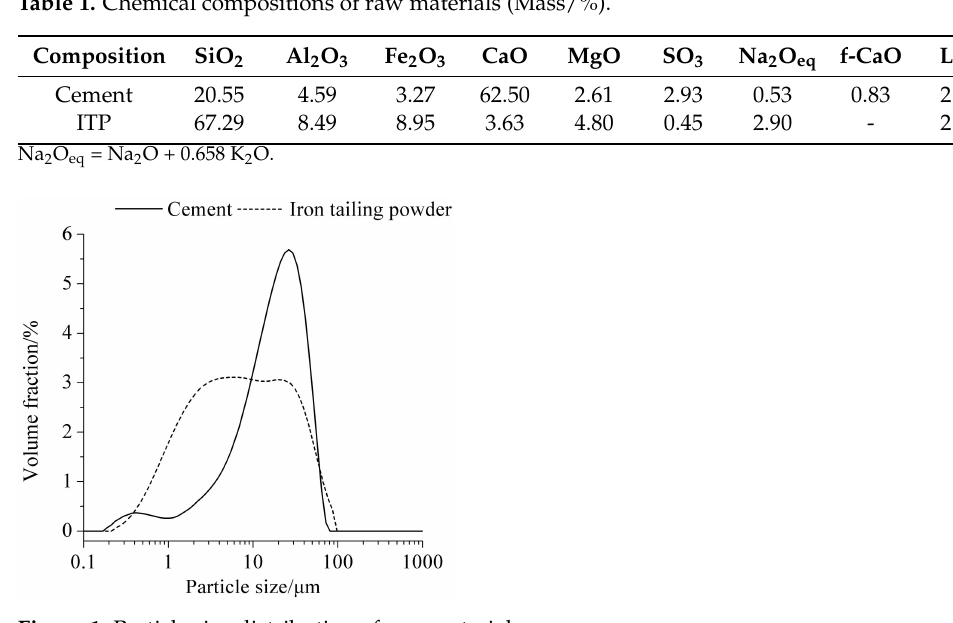
Figure 1. Particle size distribution of raw materials.